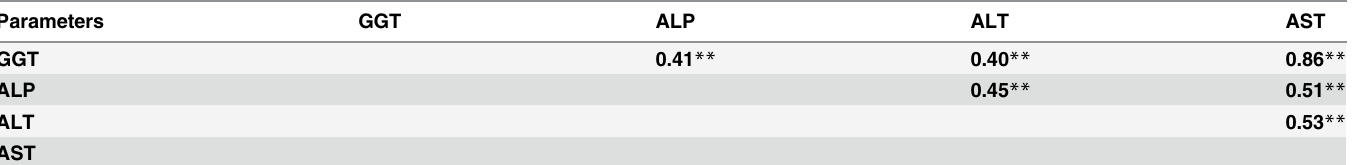
Table 6. Pearson ’ s correlation matrix of hepatic enzymes amongst the HIV — Control group.